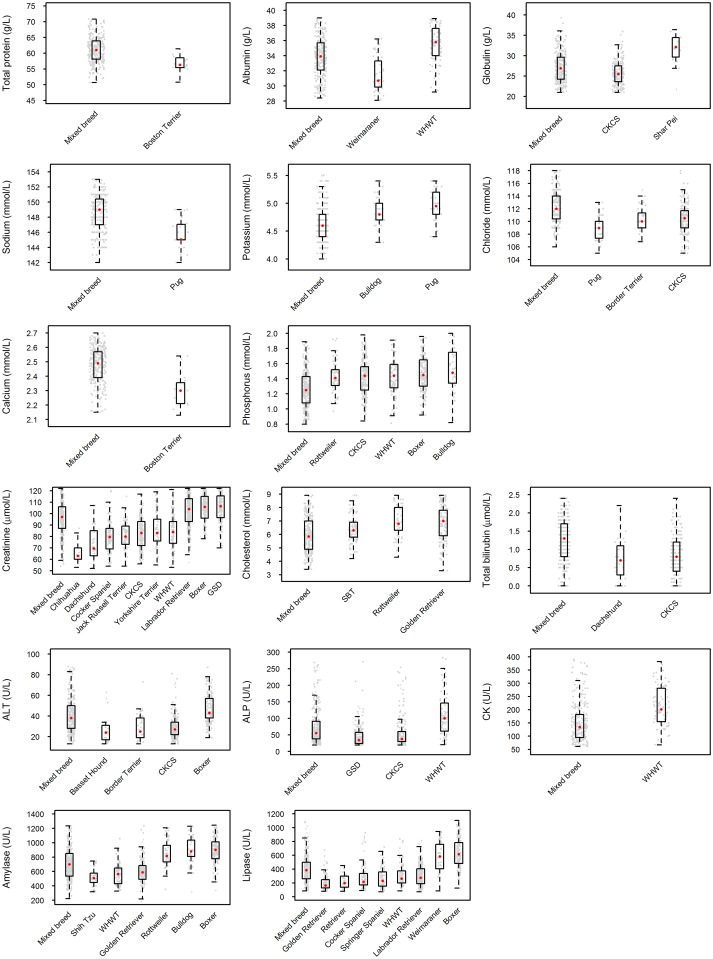
Combined box-and-whisker / dot plots representing serum biochemical data from breeds showing a significant difference from the mixed breed group for each of the 16 parameters for which differences were documented.Each small dot represents an individual dog, the boxes show the respective 25th and 75th percentiles, the larger red dots median values, and the whiskers the lowest and highest data points still within 1.5 times the interquartile range of the respective lower and upper quartiles.